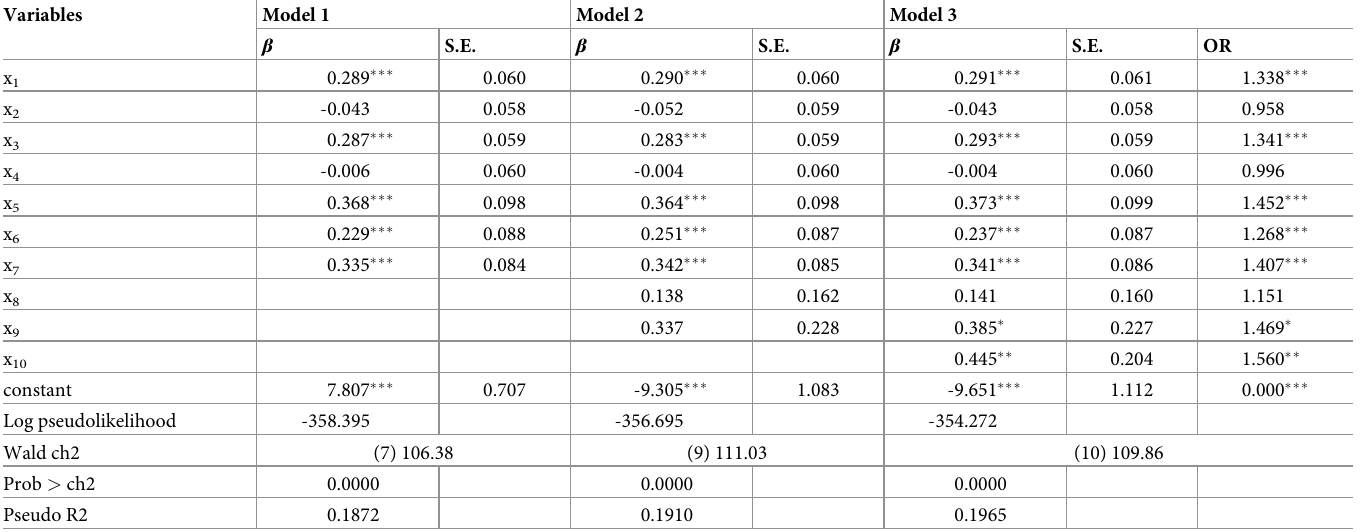
Table 6. Logistic regression for process innovation.